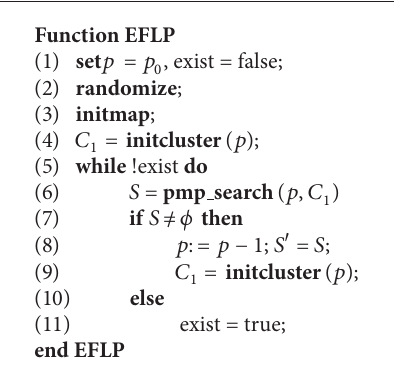
Algorithm 2: The modified VNS algorithm for the 𝑝 -median problem with a time limitation.